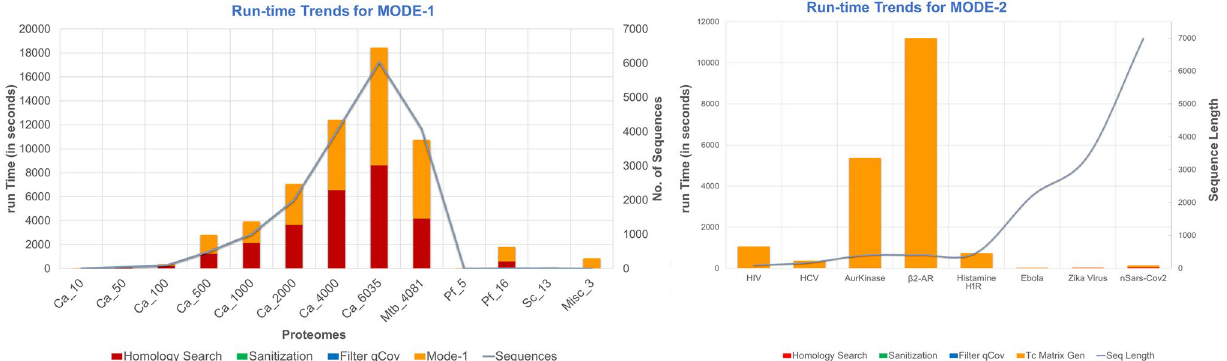
Figure 1. Performance statistics for MODE-1 and MODE-2 runs of NOD server with default settings. MODE-1 (left) is run against multiple sequence input data with different number of sequences (y 2 -axis) and run-time (y 1 -axis) is catalogued. With a gradual increase in No. of sequences (from 10 to 6035) using Candida albicans proteome, a non-linear increase in run-time is observed at Ca_1000 to Ca_2000. However, a comparison between the mode-1 runs of Ca_4000 and 4081 sequences of Mtb (Mtb_4081) shows that the run-time complexity is not essentially linear. It takes longer for Ca_4000 than Mtb_4081. Other protein sequence input includes: Plasmodium falciparum (Pf), nSARS-Cov2 (Sc), and miscellaneous set of 3 sequences comprising an Aurora Kinase and two GPCRs. For MODE-2 (right), it is evident that the computation time is independent of the sequence length as well. While Aurora-A Kinase (AurKinase), Beta-2 Adernergic Receptor (β 2 -AR) are relatively short sequences of 403 and 413 residues, their run-time ranges are very high in the order of 95 min to 197 min, respectively. Other sequences include: protease of HIV and HCV, RNA polymerase of Ebola, and Genome polyprotein of Zika